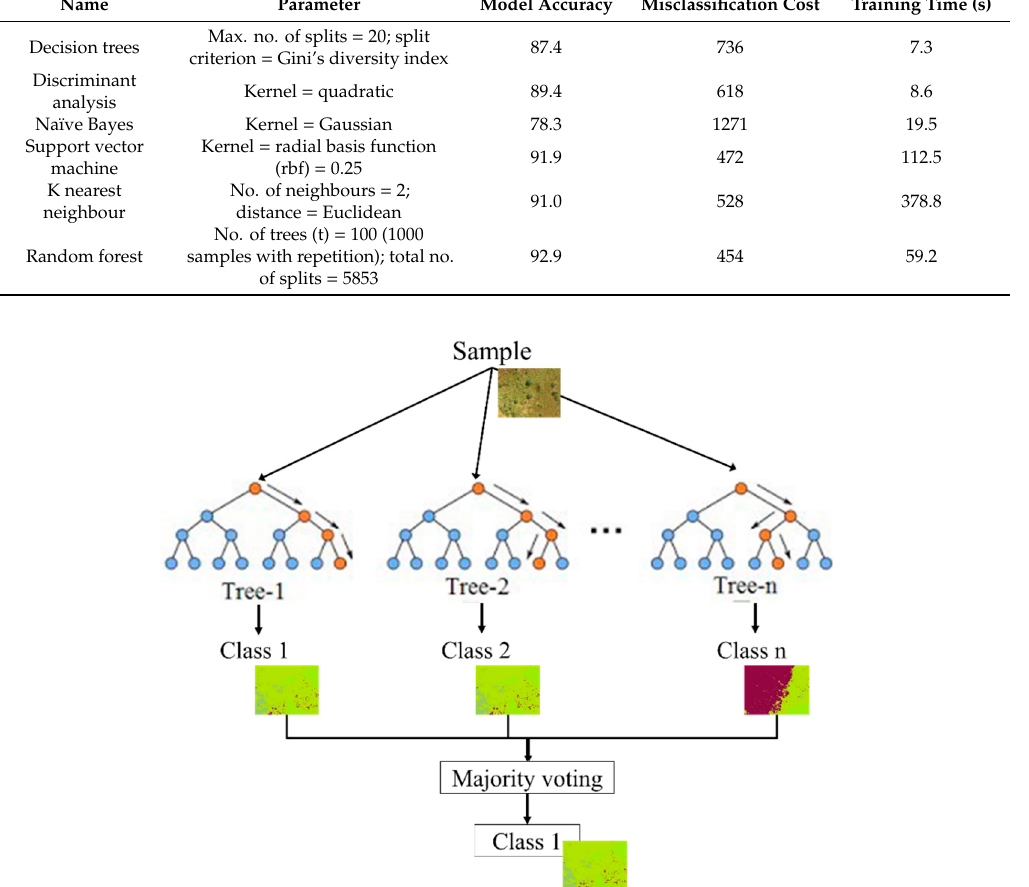
Figure 3. Workflow—random forest classifier.